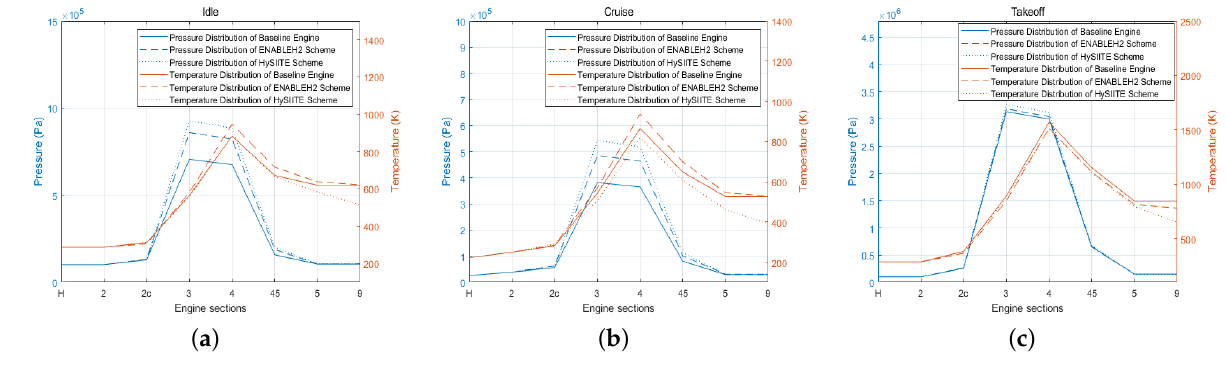
Figure 11. Comparison of temperature and pressure parameters of different engine sections: ( a ) temperature and pressure distribution at idle state; ( b ) temperature and pressure distribution at cruise state; and ( c ) temperatureand pressure distribution at takeoff